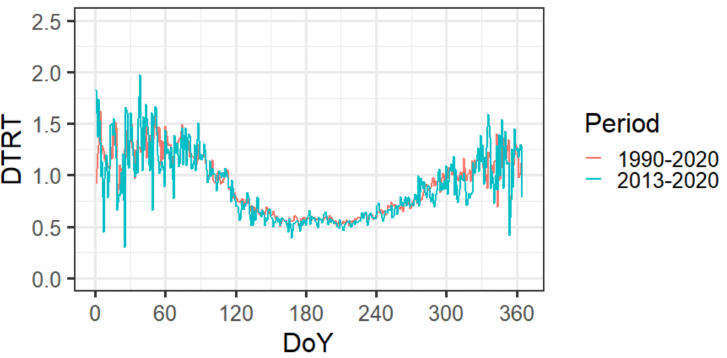
Figure 10. DTRT annual trend for 1990–2020 (red) and 2013–2020 (blue)